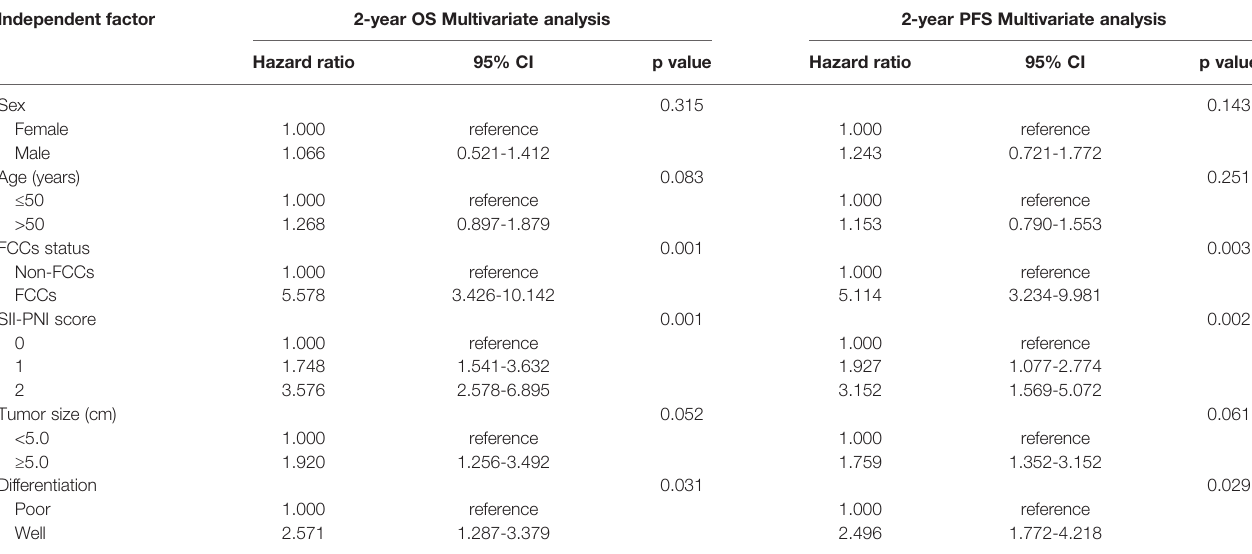
TABLE 4 | Multivariate analysis of the clinicopathological characteristics for the prognosis of GC-CY 1 patients. Independent